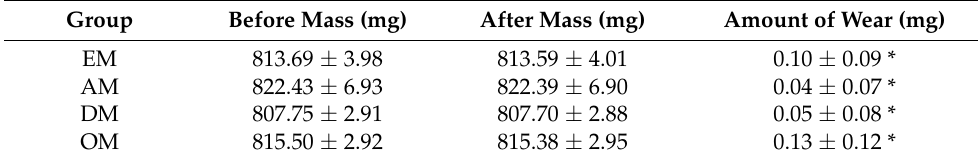
Table 2. Comparison of wear degree by mass for each group.